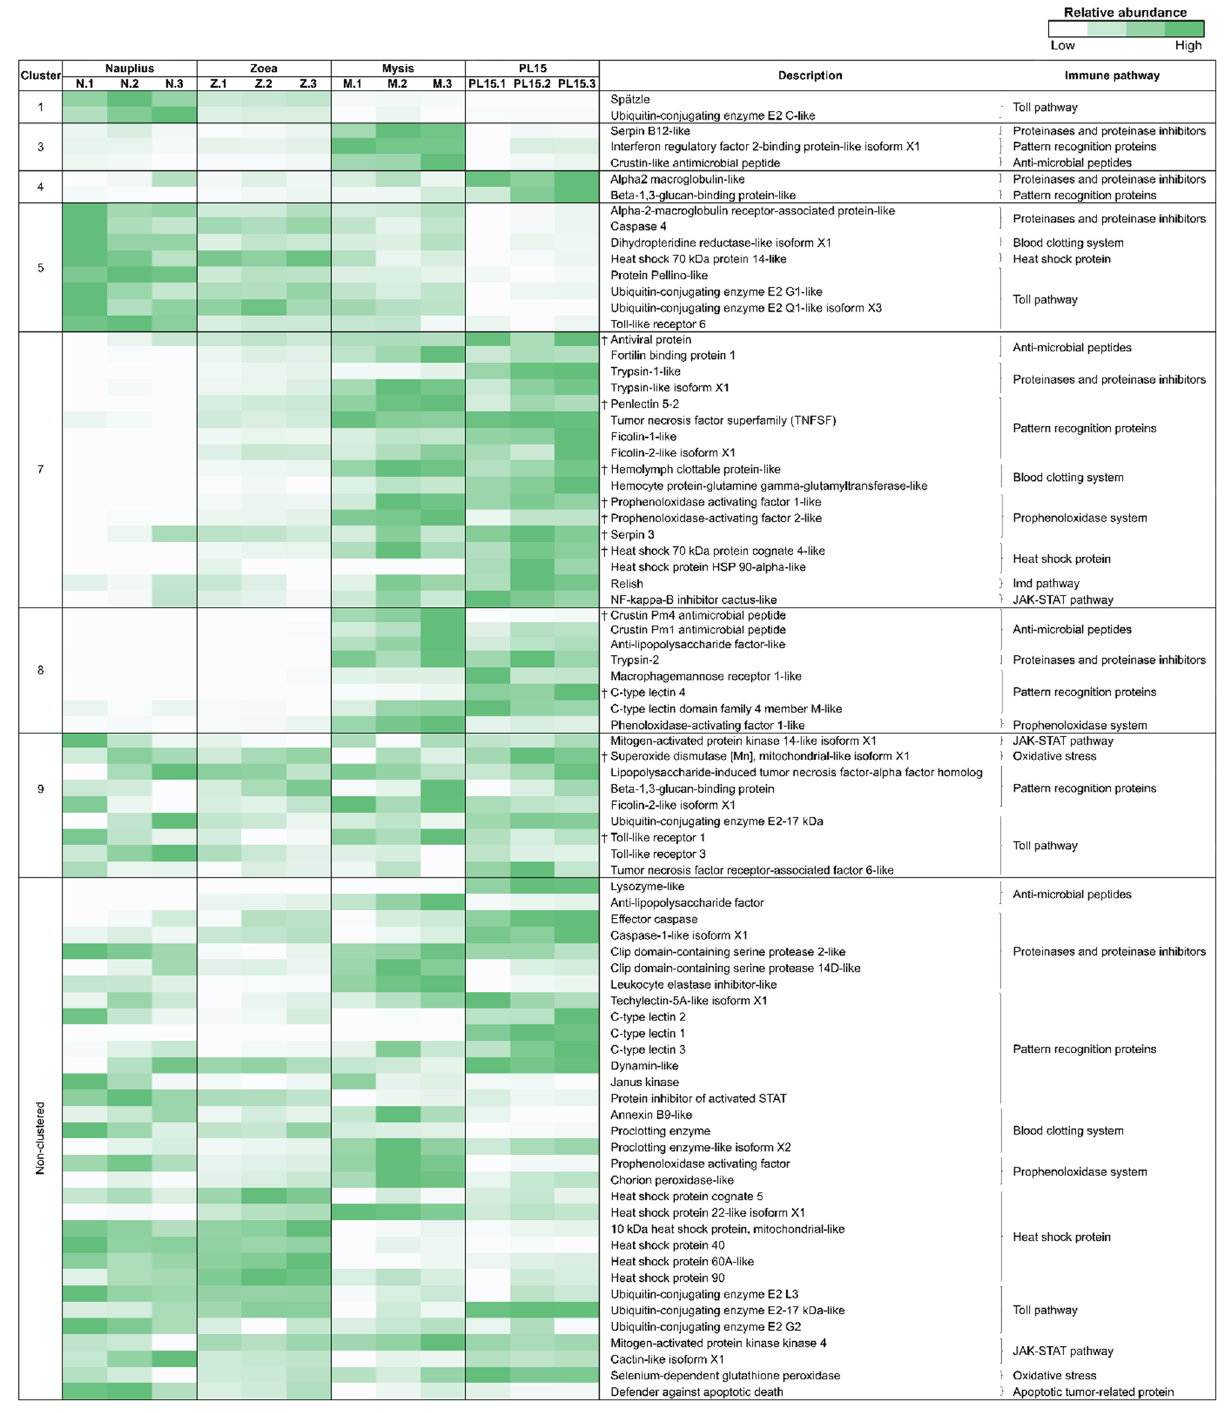
Figure 4. Heatmap showing the enriched transcripts involved in immune responses in early life stages of black tiger shrimp, including nauplius (N), zoea (Z), mysis (M) and 15-day-old postlarva (PL15). The dagger (†) indicates genes that were further validated by quantitative real-time